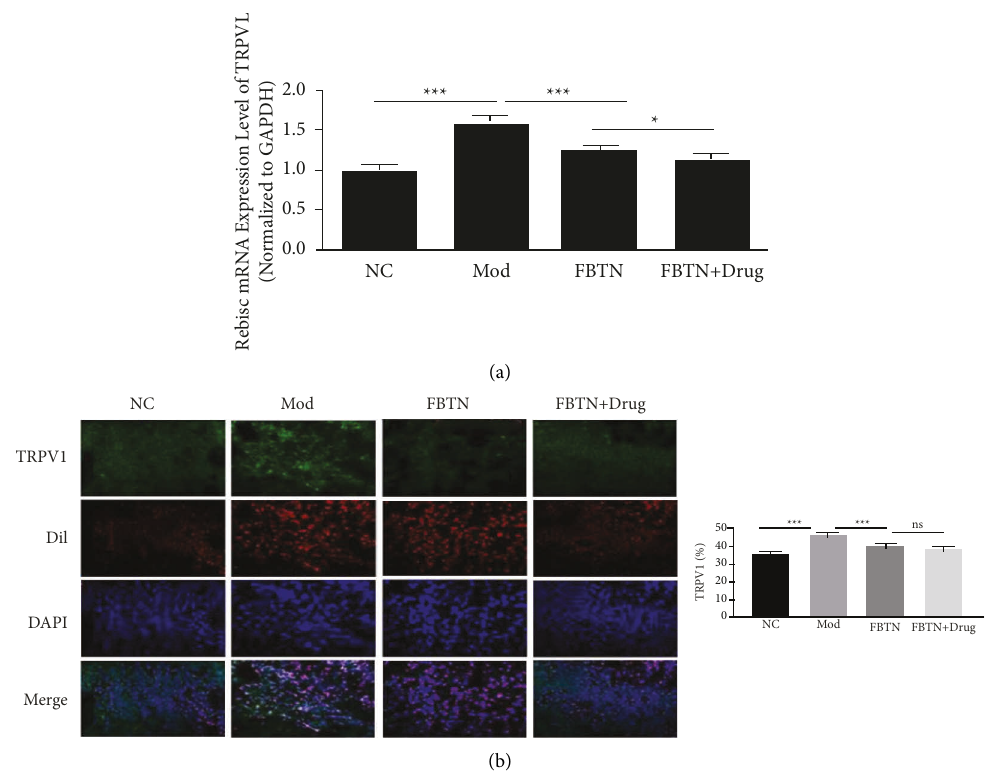
Figure 3: Effect of abdominal massage on TRPV1 expression. (a) Relative mRNA expression of TRPV1 in small intestinal mucosa tissues from the normal, IBS, abdominal massage, and ketotifen treatment groups. (b) Immunofluorescence (IF) images of TRPV1 staining in small intestinal mucosa tissue from the normal, IBS, abdominal massage, and ketotifen treatment groups (left panel) and percentage of TRPV1- positive staining (right panel). ∗ P < 0 . 05, ∗∗ P < 0 . 01, ∗∗∗ P < 0 .